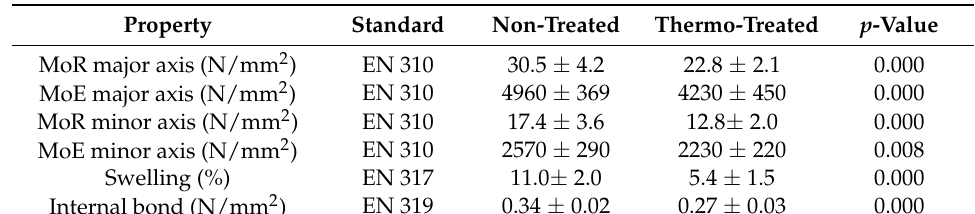
Table 1. Properties, reference standards, average values with standard deviation determined for non-treated and treated boards, and results of the t -test ( p -values).